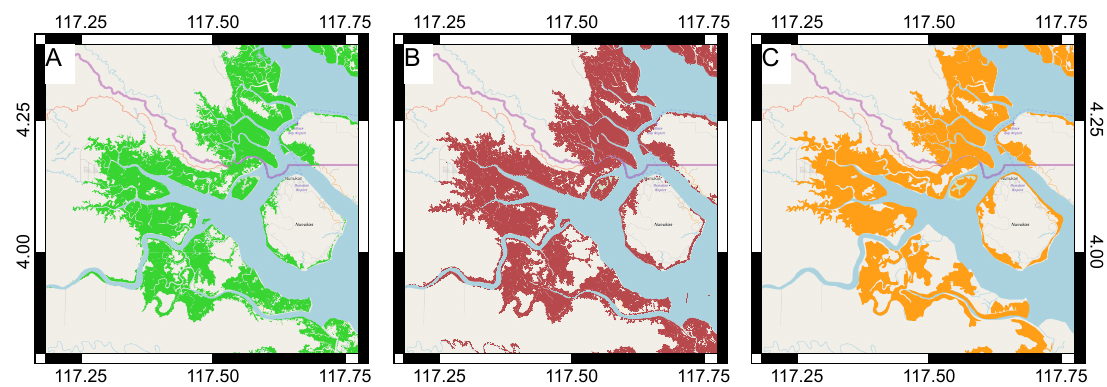
Figure 8. Border of North Kalimantan, Indonesia, and Sabah, Malaysia, illustrating a typical region with good correspondence between the GMW v2.0 baseline and the Giri et al. [1] and Spalding et al. [2] products: ( A ) GMW v2.0 baseline; ( B ) Giri et al. [1]; and ( C ) Spalding et al. [2]. Background maps: Open Street Map.